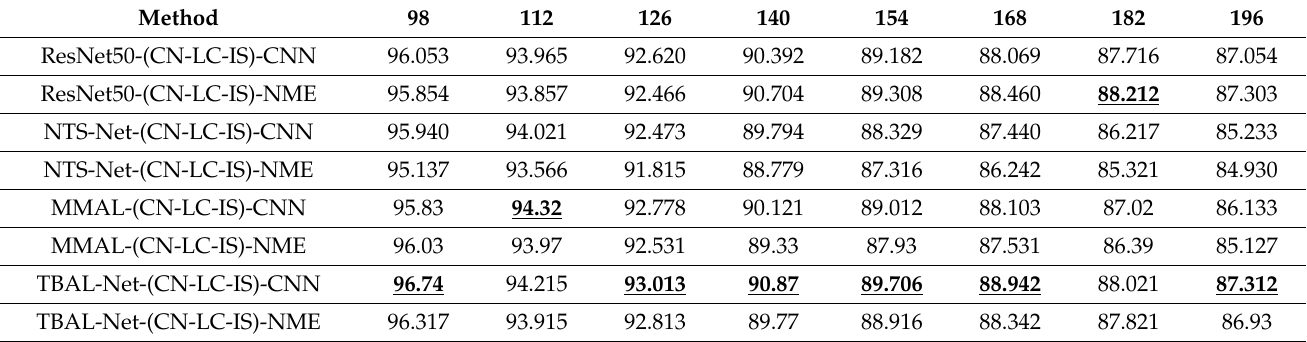
Table 8. Performance (Top-1 Accuracy %) on Stanford-Car as the number of classes increases from 98 to 196.